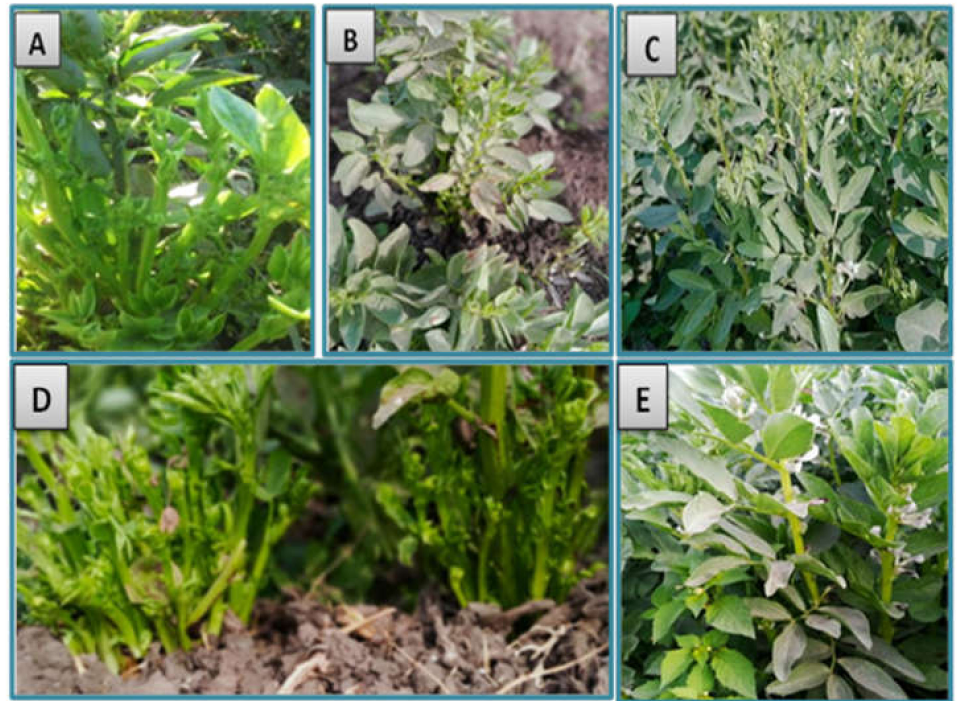
Figure 6. Effect of treatments with boric acid (BA-NPs), salicylic acid (SA-NPs), and glycyrrhizic acid (GA-NPs) nanoparticles on symptoms of phytoplasma-infected faba bean plants at the best concentrations of 0.124, 0.28, and 1.68 µ M ( A – C ), respectively, compared with phytoplasma-positive control ( D ) and healthy control ( E ).